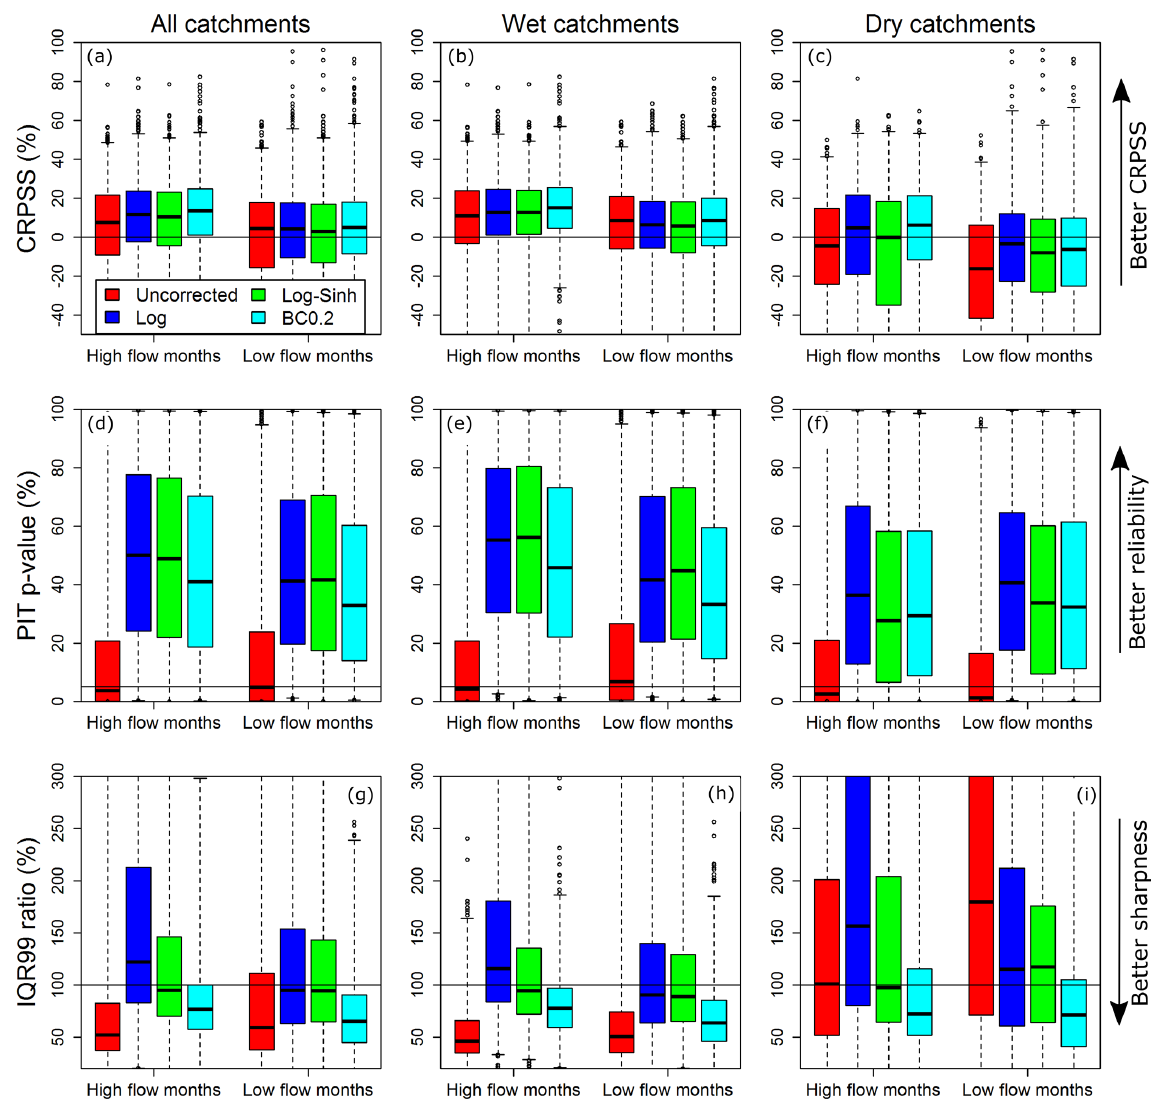
Figure 5. Performance of seasonal forecasts in terms of CRPSS, reliability (PIT p -value), and sharpness (IQR99